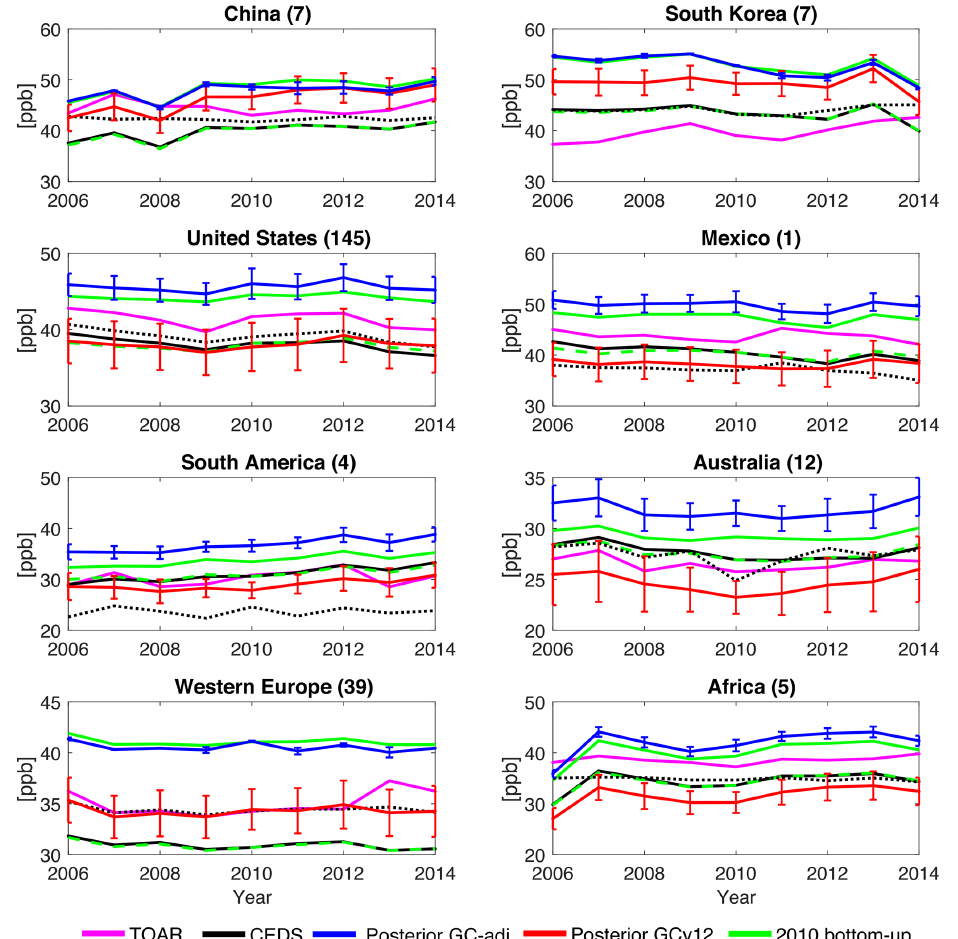
Figure 8. The trends of regional mean annual MDA8 ozone concentrations from 2006 to 2014. Surface measurements are from the TOAR database (magenta line). Only sites that have continuous measurements throughout the 9 years are included. The numbers in the parenthesis are the number of 2 ◦ × 2 . 5 ◦ grid cells that include monitoring sites in each region. The black dotted lines show the national mean of surface ozone from GCv12 simulations using the CEDS inventory. The other lines are simulations from GC-adj and GCv12 averaged over the 2 ◦ × 2 . 5 ◦ grid cells that include monitoring sites. Black lines show ozone simulations using the bottom-up NO x emissions from CEDS in each corresponding year. Green lines show ozone simulations using 2010 bottom-up NO x emissions for all years (HTAP 2010 for GC-adj shown in solid lines, CEDS 2010 for GCv12 shown in dashed lines). The vertical bars represent the spread of simulated surface ozone concentrations using the NASA and the DOMINO posterior NO x